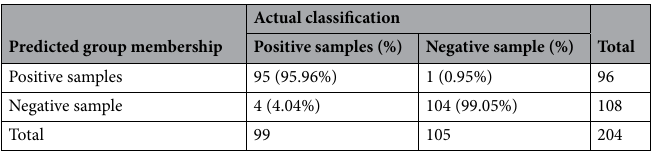
Table 4. Classification results of jackknife cross-validation method. McNemar’s test: P = 0.375.